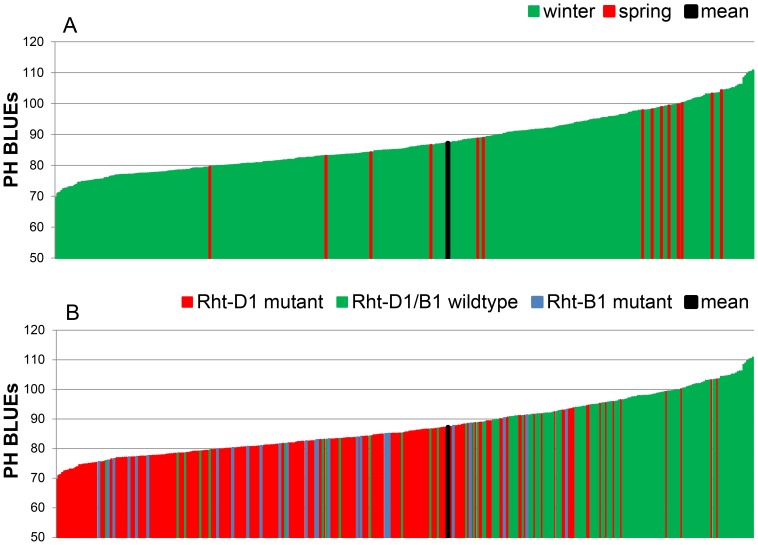
Phenotypic distribution of plant height BLUEs in 372 wheat varieties.The BLUEs for plant height were calculated across eight environments. Plant height BLUEs were arranged according to growth habit (A) or the distribution of the mutant alleles of the dwarfing genes Rht-B1 and Rht-D1 (B).